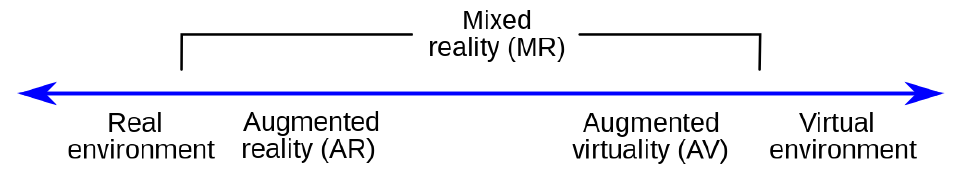
Figure 1. Milgram and Kishino reality–virtuality continuum.